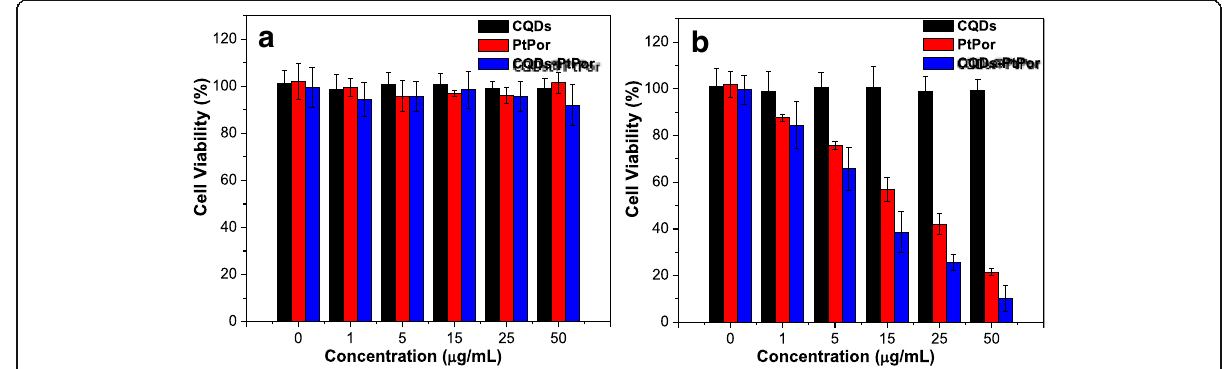
Fig. 6 Dark cytotoxicity ( a ) and photocytotoxicity ( b ) of CQDs, PtPor, and CQDs@PtPor at different